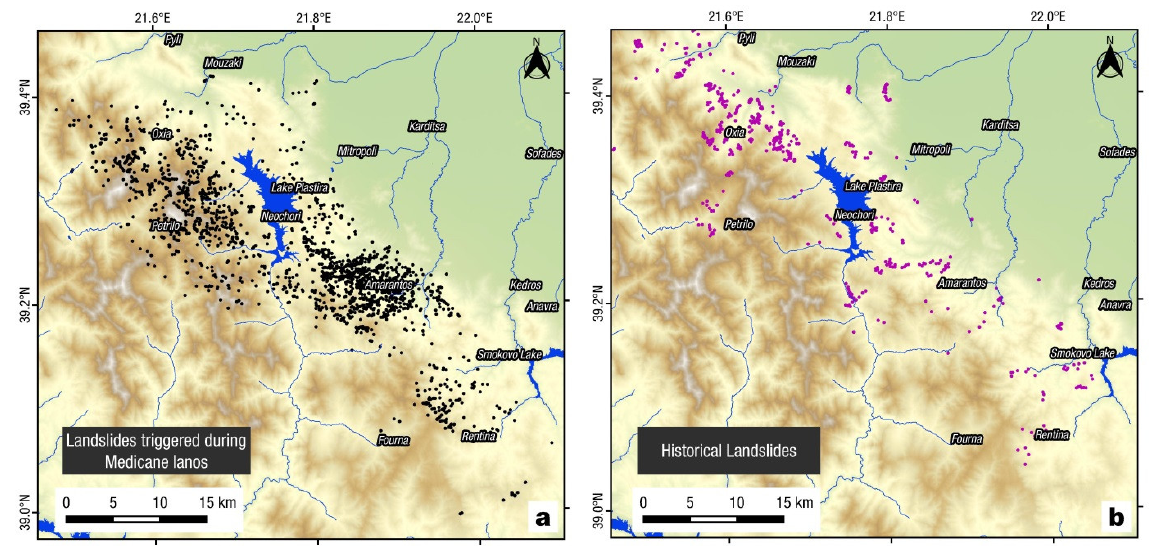
Figure 18. Comparison of ( a ) Medicane Ianos triggered landslides (black dots) and ( b ) historical occurrences of landslides in the region (purple dots).